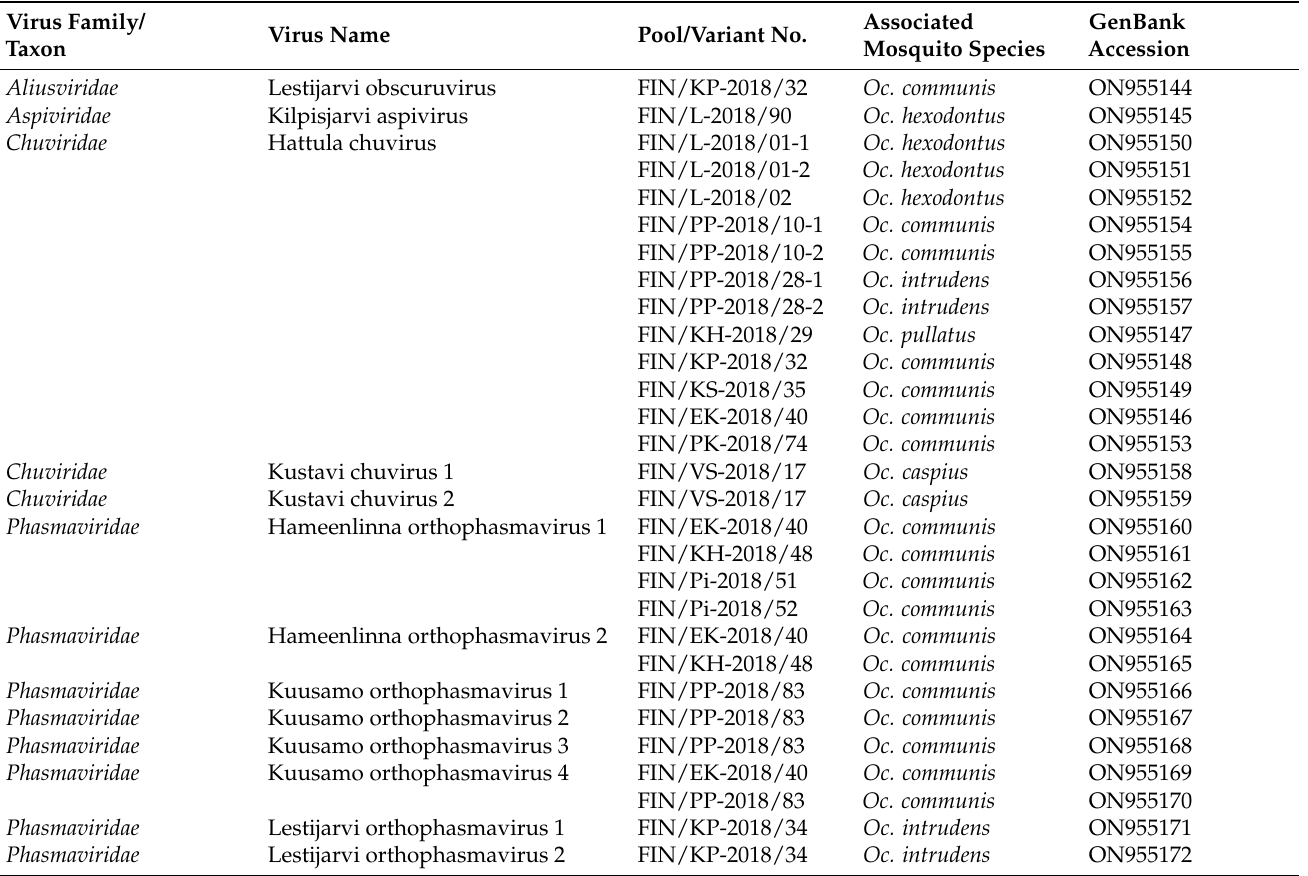
Table 3. Novel − ssRNA viruses sequenced from Finnish mosquitoes, part 1. Where more than one virus was sequenced from a pool, an additional code was appended to the pool